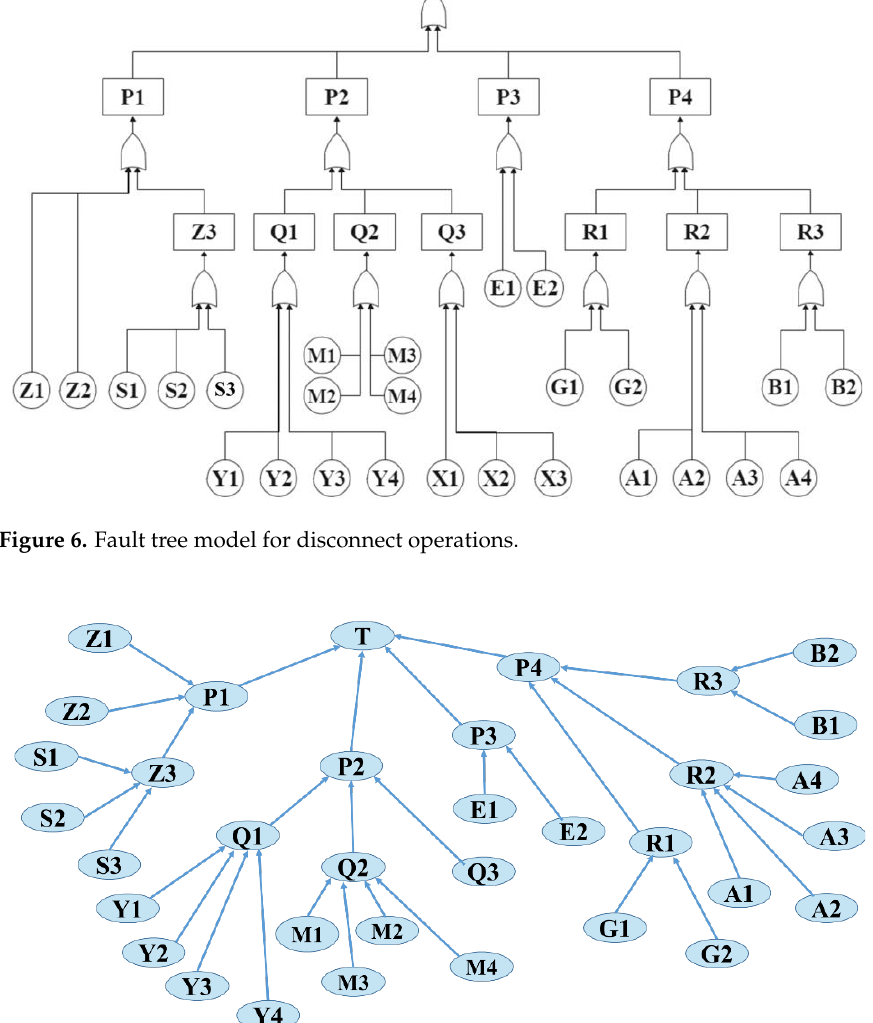
Table 8. Fuzzy number sets of the scale.